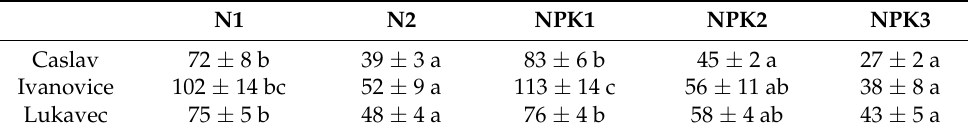
Figure 2. The effect of different N doses on spring barley grain yield (t ha − 1 ) in Caslav, Ivanovice and Lukavec. The data (black dots) is interpolated by a linear-plateau model (blue line) Table 4. The AE (kg kg − 1 ) of analyzed fertilizer treatments as affected by the locality (2013–2016).